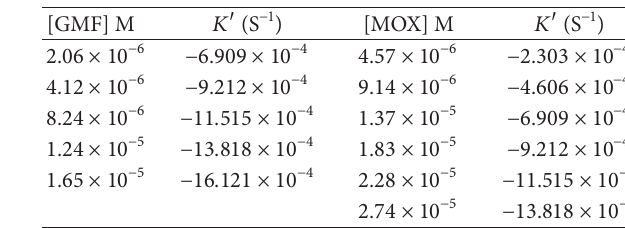
Table 4: Values of rate constant 𝐾 󸀠